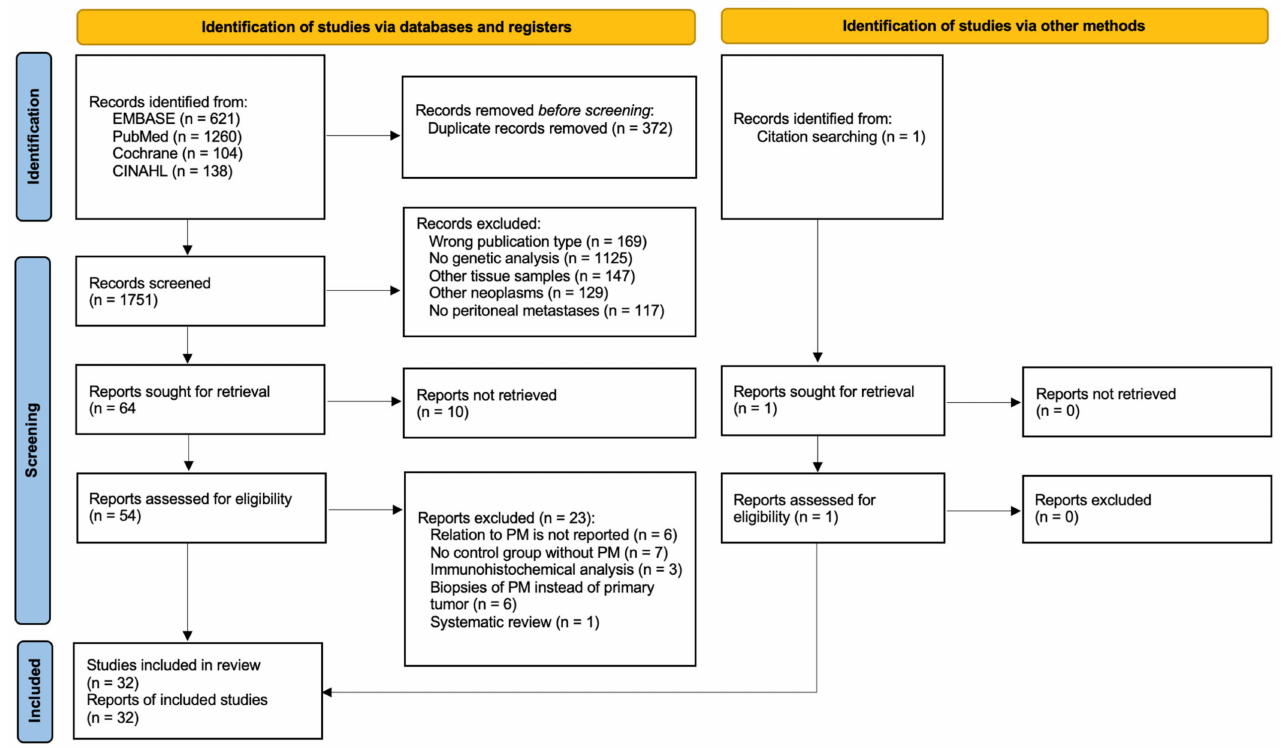
Figure 1. PRISMA flowchart outlining study selection strategy